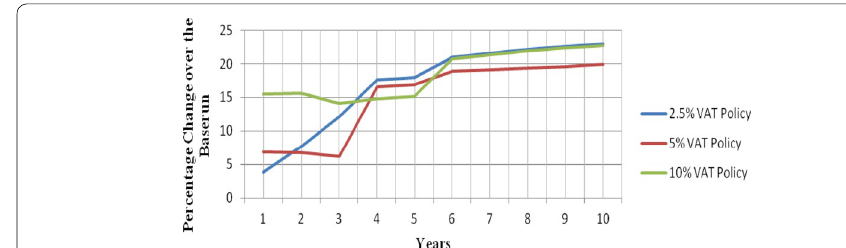
Fig. 4 Impact of VAT policy on total government revenue